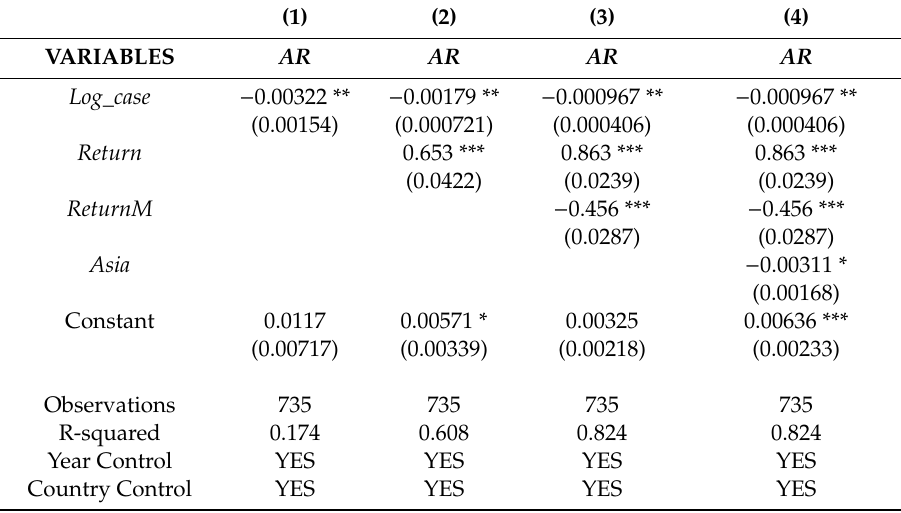
Table 12. OLS regression results of COVID-19 confirmed cases and stock market indices